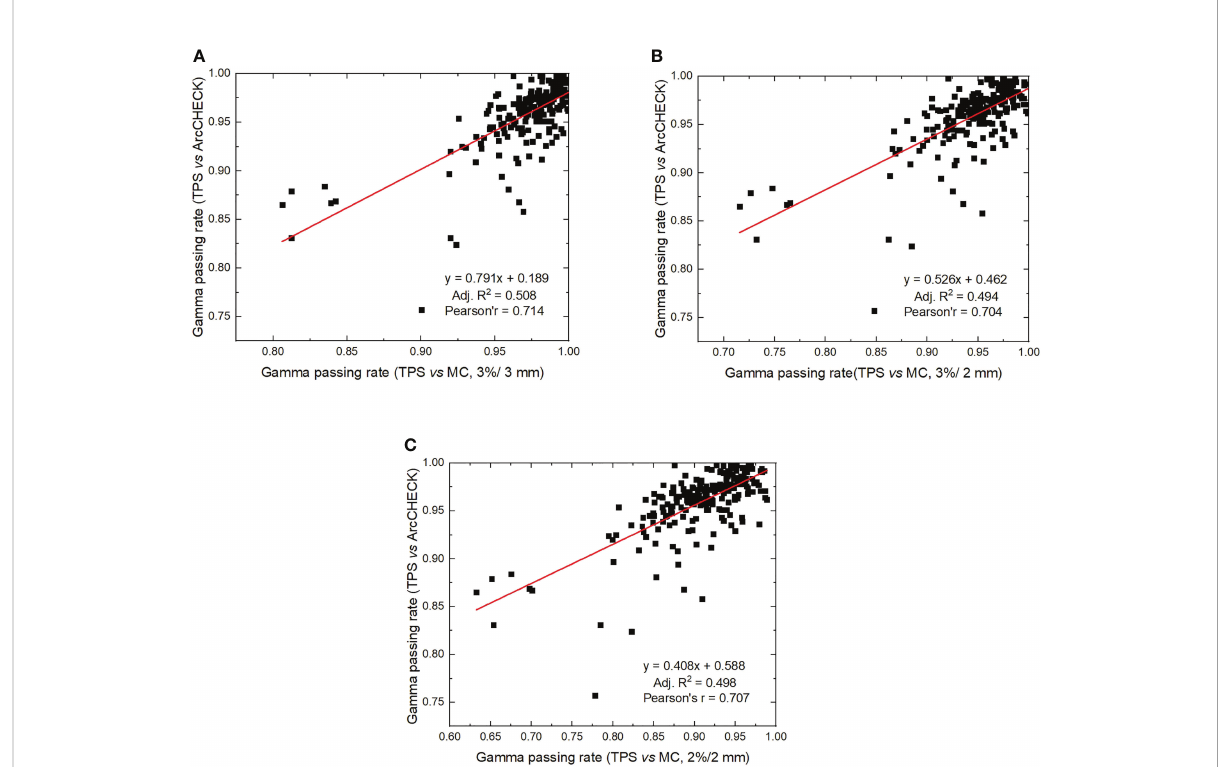
FIGURE 3 Correlation analysis between gamma passing rates calculated by ArcCHECK measurements (TPS vs measurements) and gamma passing rates calculated by ArcherQA (TPS vs MC). (A) 3%/3 mm criterion, (B) 3%/2 mm criterion, (C) 2%/2 mm